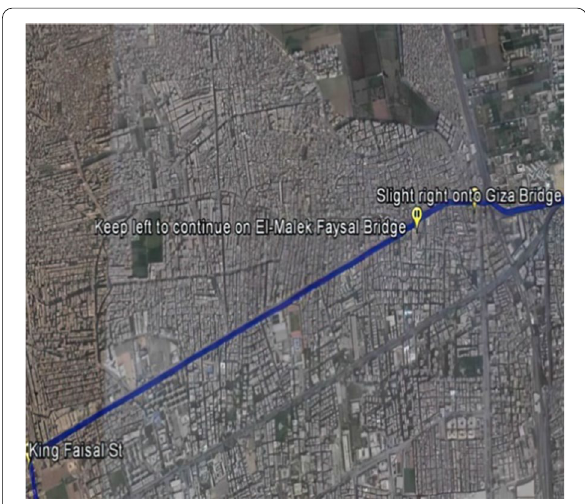
Fig. 2 Measurement locations in Faysal region, blue line refers to measurement